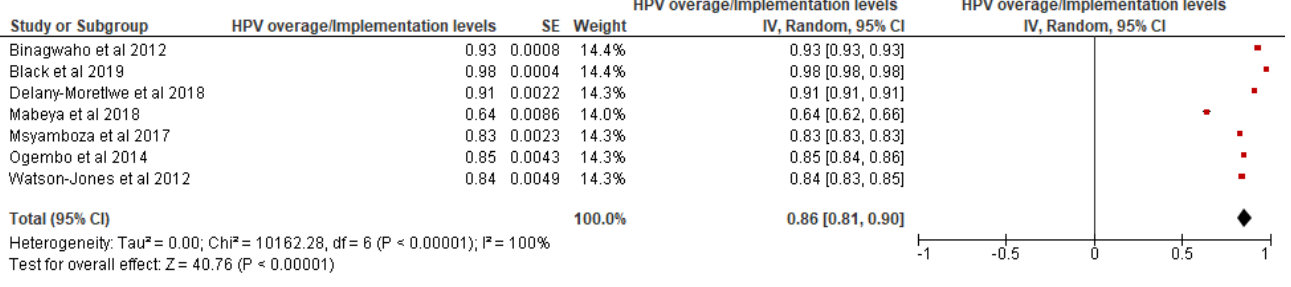
Figure 4. Cervical cancer survival rate. Source: [13,25,40,46].